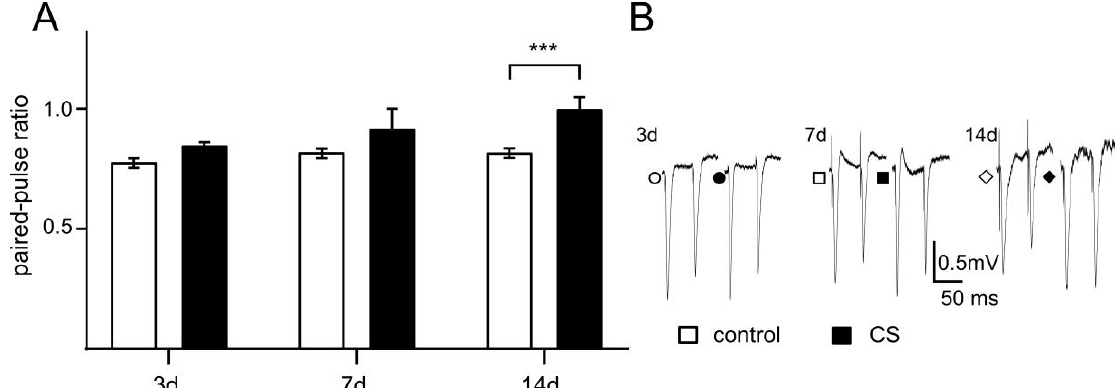
Figure 4. The influence of CS on paired-pulse ratio (PPR) in recordings from FC slices. A —Comparison of PPR in CS 3d ( n = 8) vs. control ( n = 11); CS 7d ( n = 19) vs. control ( n = 19) and CS 14d ( n = 19) vs. control ( n = 9), respectively. B —Examples of individual FPs evoked by paired stimuli in slices from control (open shapes) and after CS stress (filled shapes). Shapes of symbols corresponding to appropriate animal groups (circles–3 days, squares–7 days, and diamonds–14 days of treatment). *** p < 0.0001 vs. control (post-hoc Sidak’s test).